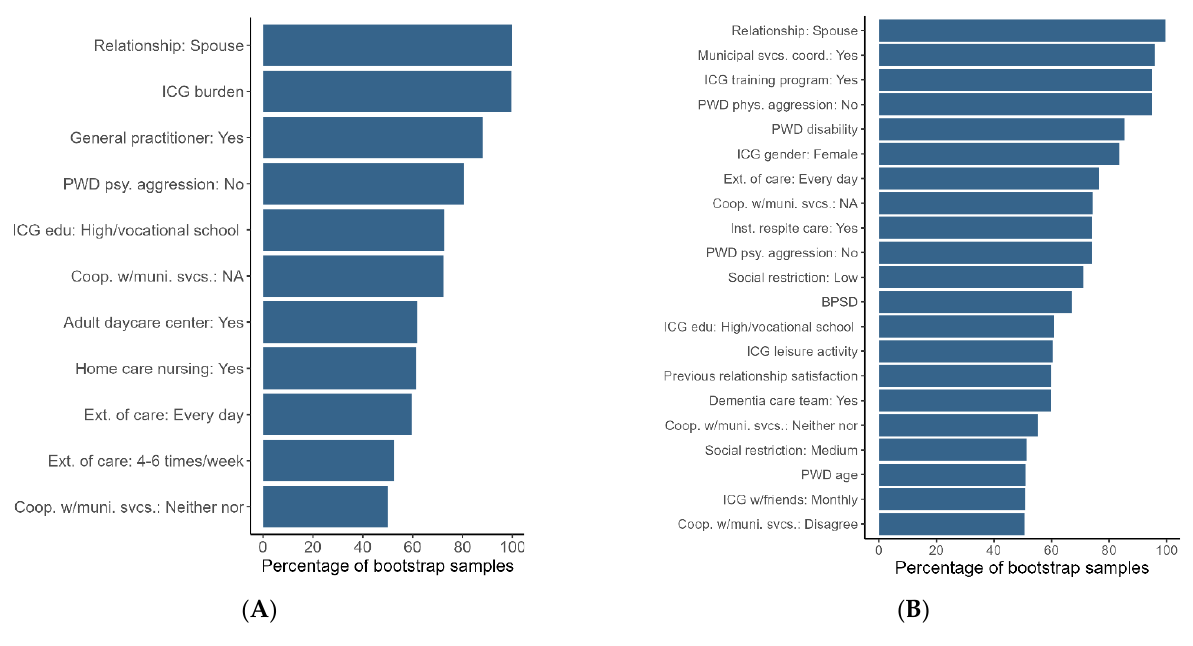
Figure 4. Covariates selected in >50% of the 1,000 bootstrap samples in percent not null. Outcome variables: ( A ) psychological abuse; ( B ) physical abuse.